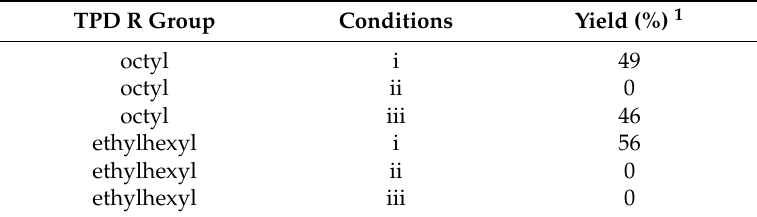
Table 1. Reaction results for conditions i, ii, and iii with octTPD and ehTPD. (i) Toluene, 120 ◦ C, Cs 2 CO 3 , pivalic acid, and Pd(Herrmann-Beller, and P( o -anisyl) 3 ; (ii) DMA, 80 ◦ C, Cs 2 CO 3 , pivalic acid, and Silia Cat ® DPP-Pd; and (iii) toluene, 120 ◦ C, Cs 2 CO 3 , pivalic acid, and Silia Cat ® DPP-Pd. TPD R Group Conditions Yield (%) 1 octyl i 49 octyl ii 0 octyl iii 46 ethylhexyl i 56 ethylhexyl ii 0 ethylhexyl iii